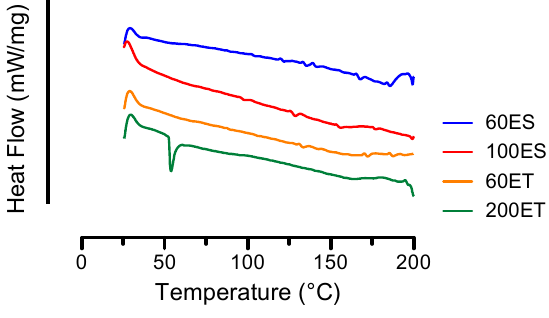
Figure 3. DSC thermograms of the various PU films from 25 to 200 ◦ C, where a thermal endotherm at approximately 50 ◦ C for the 200ET groups corresponds to melting of the soft segments.